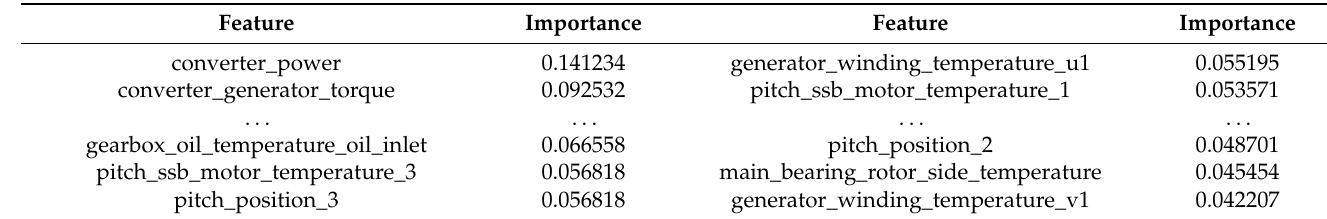
Table 3. Feature importance.